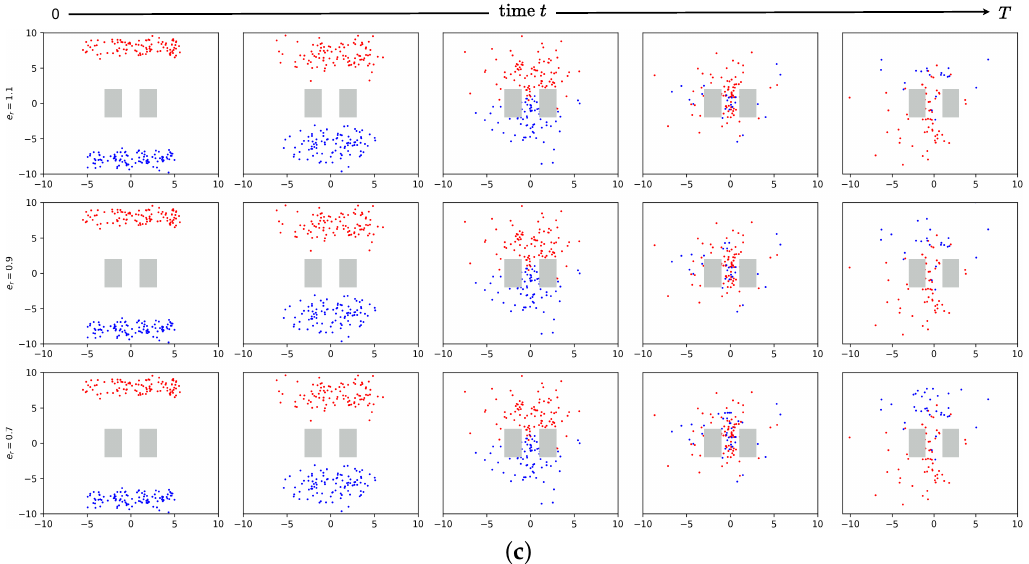
Figure 5. Vertical view of the large-scale UAV attack and defense behaviors under different stochas- ticity parameters and different capture radii. ( a ) Snapshots of the distributions of the UAVs’ locations under different capture radii when ν = 0; ( b ) Snapshots of the distributions of the UAVs’ locations under different capture radii when ν = 0.04; ( c ) Snapshots of the distributions of the UAVs’ locations under different capture radii when ν = 0.08.